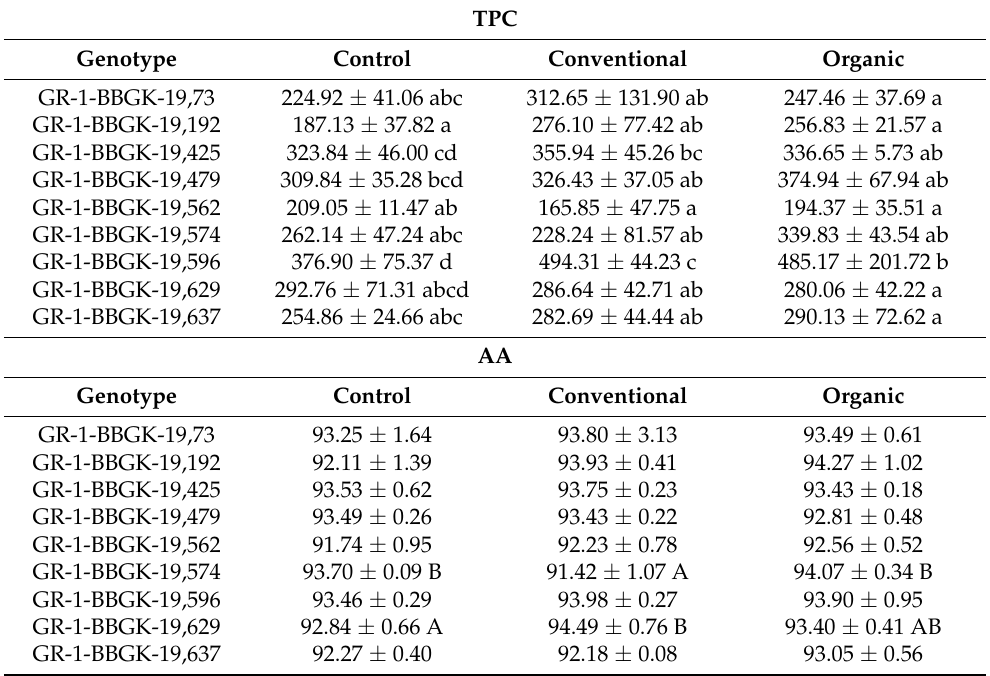
Table 6. Effect of fertilization regimes (conventional, organic, and control with no